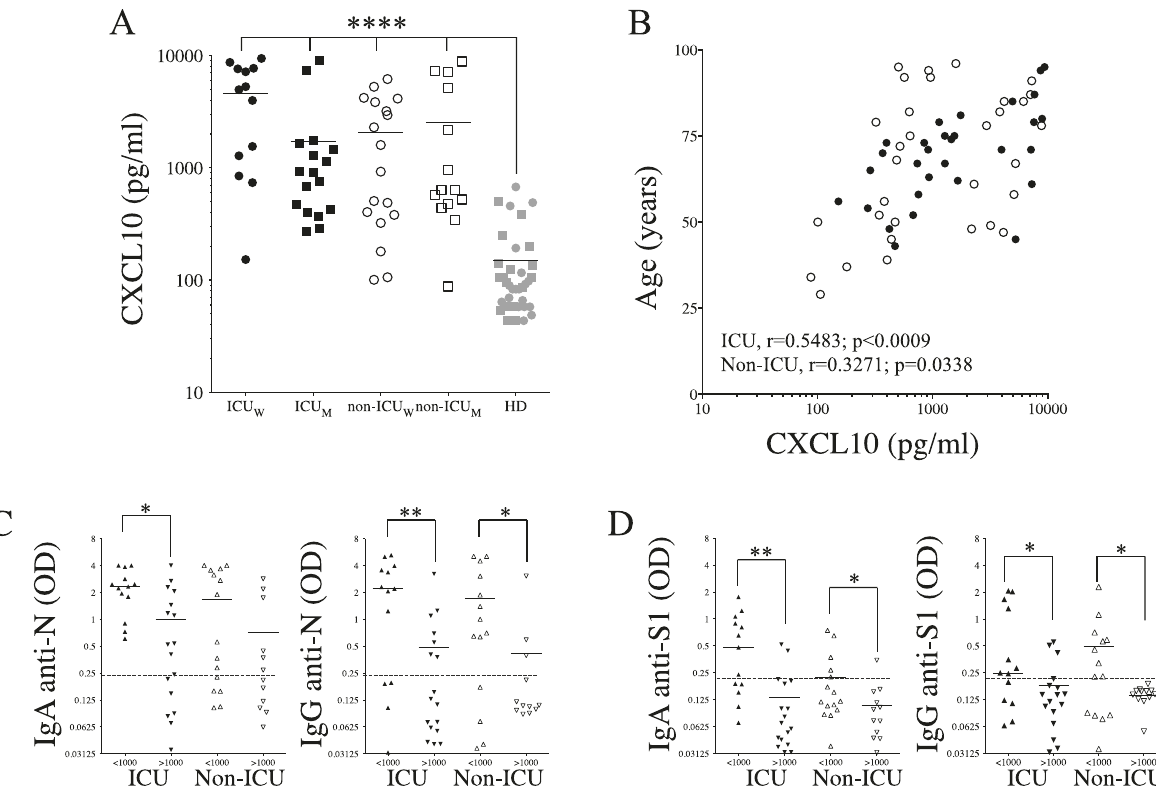
Fig. 7 Relationship between levels of CXCL10 and humoral response. A Levels of CXCL10. Each dot represents an individual. Back symbols are ICU, white symbols are non-ICU, and gray HDs. Circles are females (ICU W and non-ICU W ) and squares are males (ICU M and non-ICU M ). B Correlation between age and levels of CXCL10. Correlations were assessed using the Spearman test and r is indicated. IgA and IgG responses against N C and S1 D of ICU and Non-ICU with higher (>1000 pg/mL) and lower (<1000 pg/ml) of CXCL10. A nonparametric Mann – Whitney test was used for comparison ( p values: *, <0.05; **, <0.01; ***,